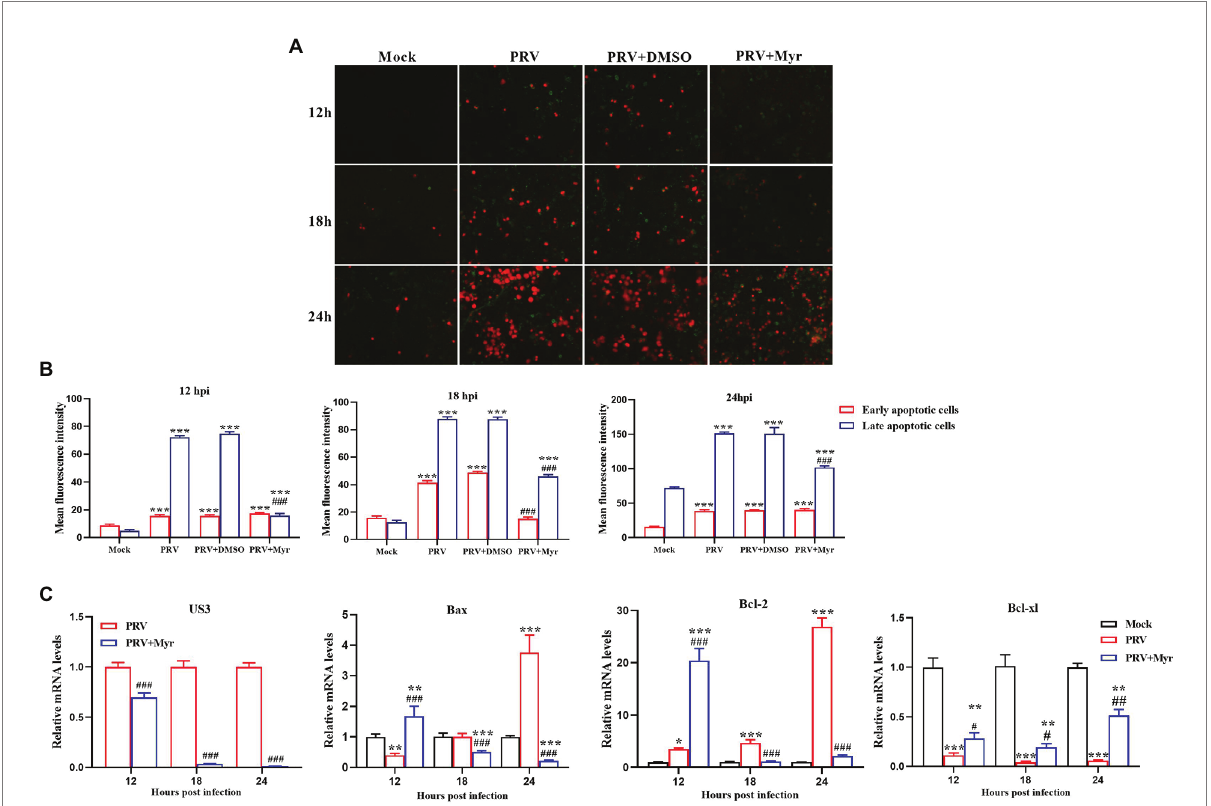
FIGURE 4 Apoptosis study. (A) Myricetin was added after the cells were infected with PRV (MOI = 0.1) for 1 h and subjected to Annexin V-FITC/PI double staining at 12, 18, and 24 hpi, respectively. Green, early period of apoptosis; Red, later period of apoptosis or necrosis. Magnification, 200X. (B) Relative fluorescence intensity was counted by using the ImageJ software. (C) Myricetin was added after the cells infected with PRV (MOI = 0.1) for 1 h and Total RNA was extracted by TRIzol reagent at 12, 18, and 24 hpi, respectively. Then, the total RNA was reverse-transcribed by Revert Aid First-Strand cDNA Synthesis Kit. Expression of each gene was determined by real-time PCR. Mock, the uninfected-untreated cells; PRV, the infected group without treatment; PRV + DMSO, the infected group with DMSO treatment (0.5%); PRV + Myr, the infected group with myricetin treatment (0.5 mM). Values are presented as means ± SD ( n = 6). Symbols “*, **, and ***” represent p < 0.05, p < 0.01, and p < 0.001, respectively, between the mock group and other groups. Symbols “#, ##, and ###” represent p < 0.05, p < 0.01, and p < 0.001, respectively, between the PRV group and other